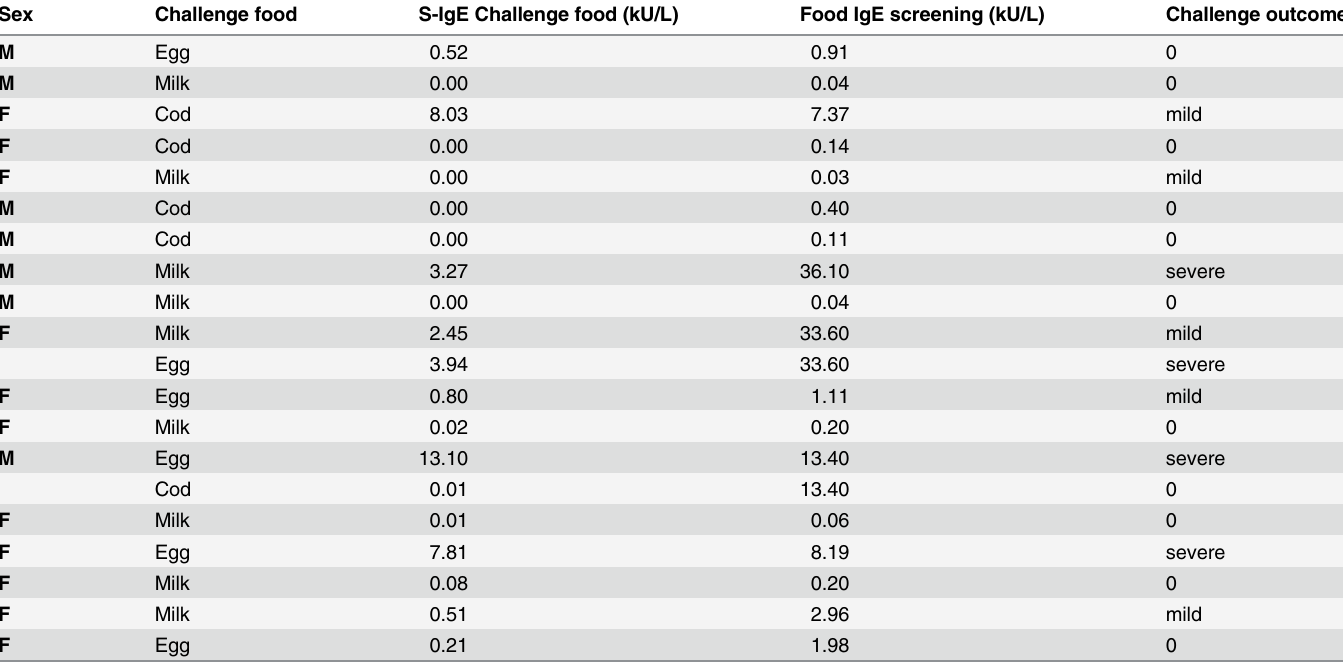
Table 3. Characteristics and challenge outcomes of the children (n = 18) who participated in the double-blind placebo-controlled food challenges